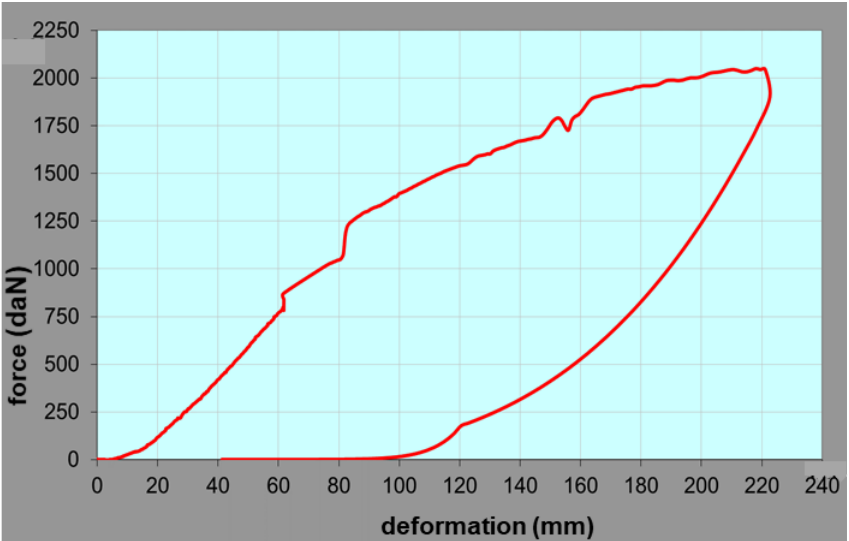
Figure 15. The plot of the plastic deformation.